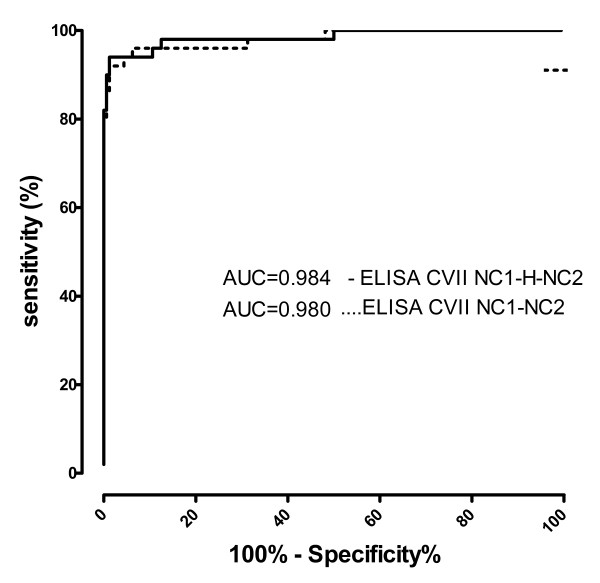
Receiver-operating-characteristic (ROC) curve. AUC, area under the curve. Test performed with sera from patients with epidermolysis bullosa acquisita (n = 50) and controls (n = 160).